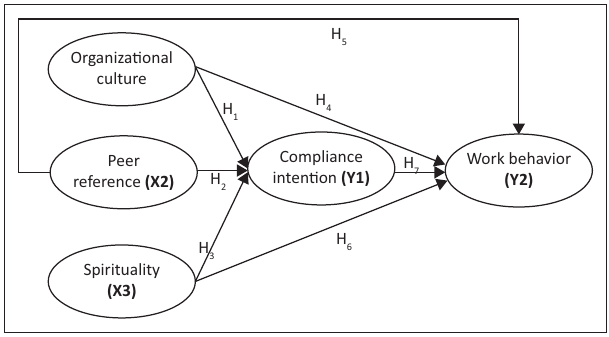
FIGURE 1: Hypotheses